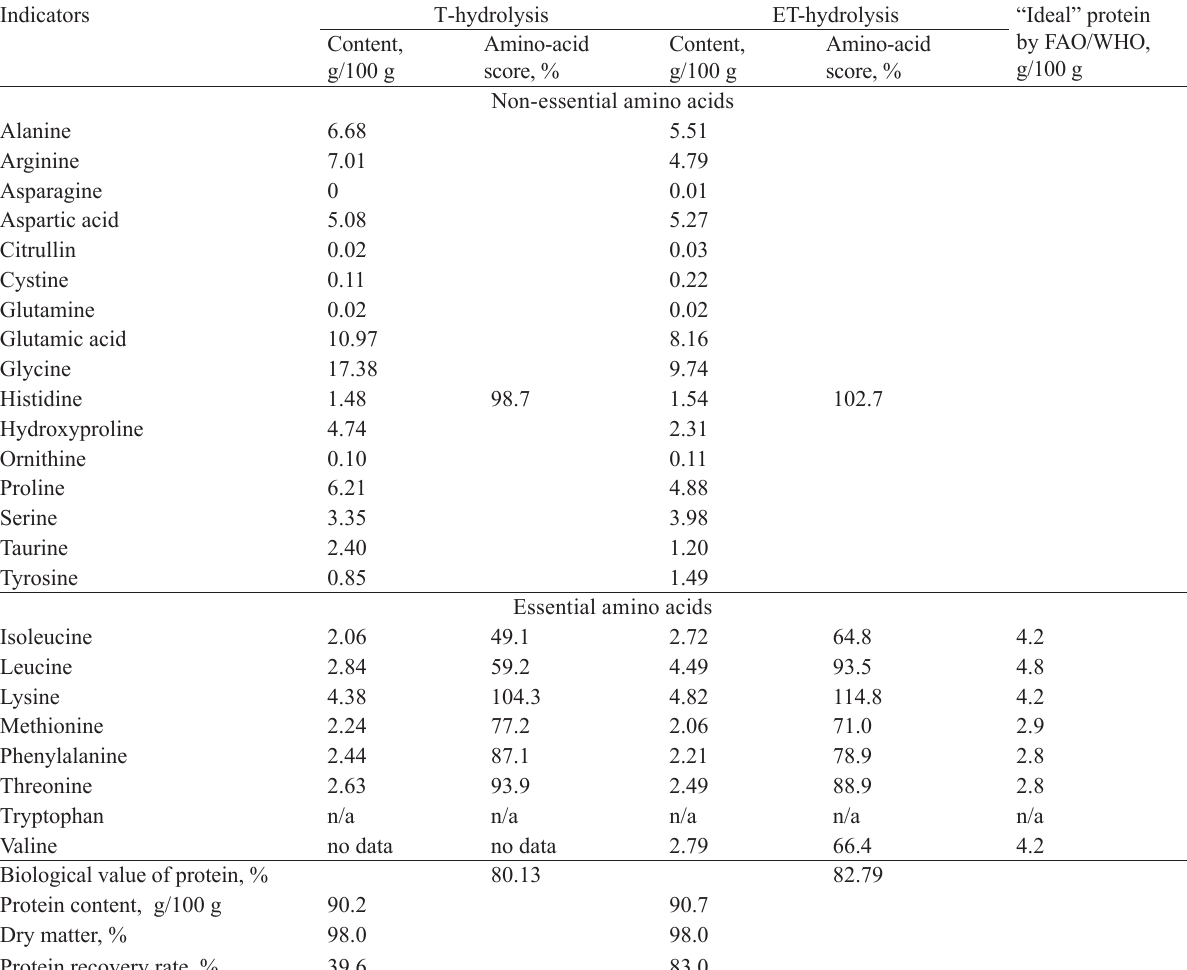
Table 4 Amino-acid profile of lyophilized protein hydrolysates from sockeye heads produced by different hydrolysis methods Indicators Т -hydrolysis ET-hydrolysis “Ideal”